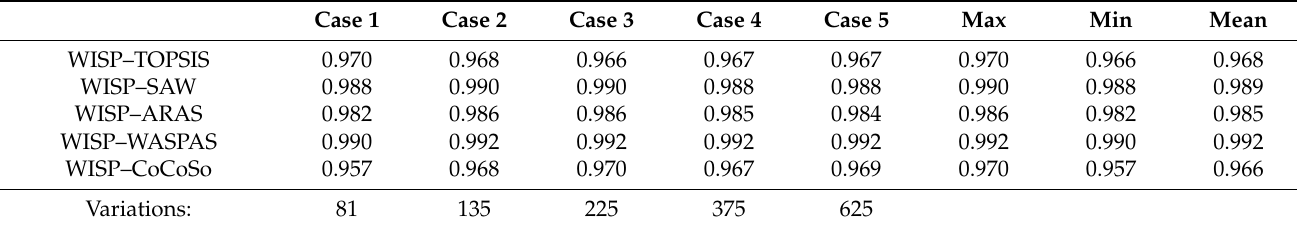
Table 10. The correlation of the ranks of alternative A 1